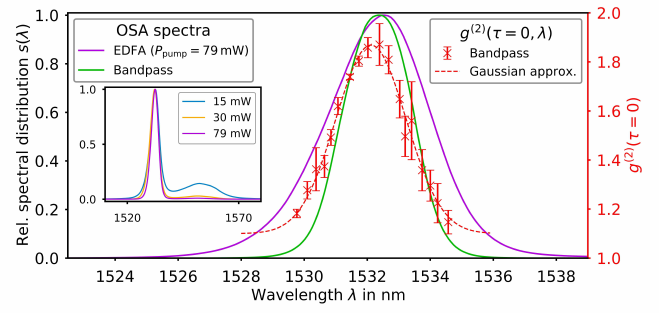
Figure 3. Measured wavelength-wavelength correlations of light emitted by the EDFA: The full optical spectrum of the EDFA (magenta solid line) has been measured by a standard optical spectrum analyzer. The selected wavelength band is also depicted (green solid line) for direct comparison with the second-order correlation data (red crosses with a dashed line based on a Gaussian fit). The error bars correspond to the standard deviation for a set of 5 measurements. The inset shows the unfiltered EDFA spectrum for three different optical pump conditions of the